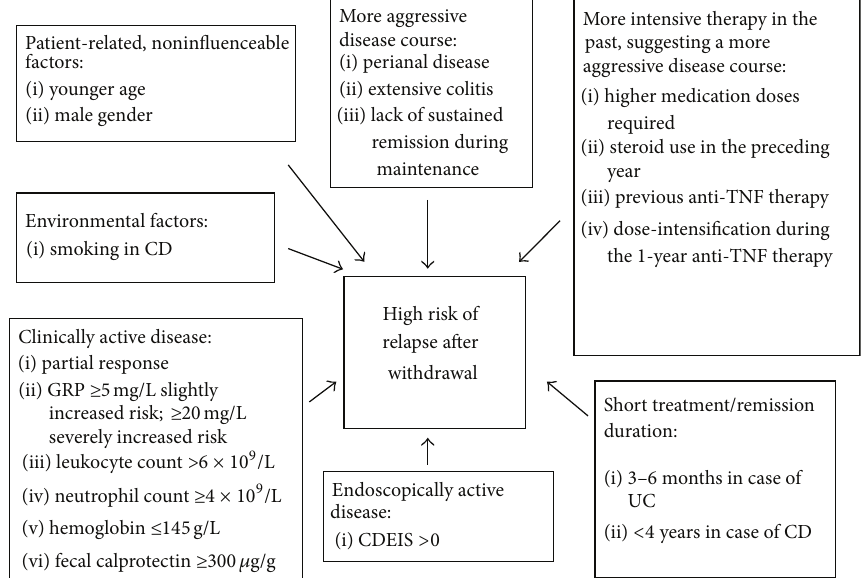
Figure 1: Risk factors predisposing to a relapse after drug